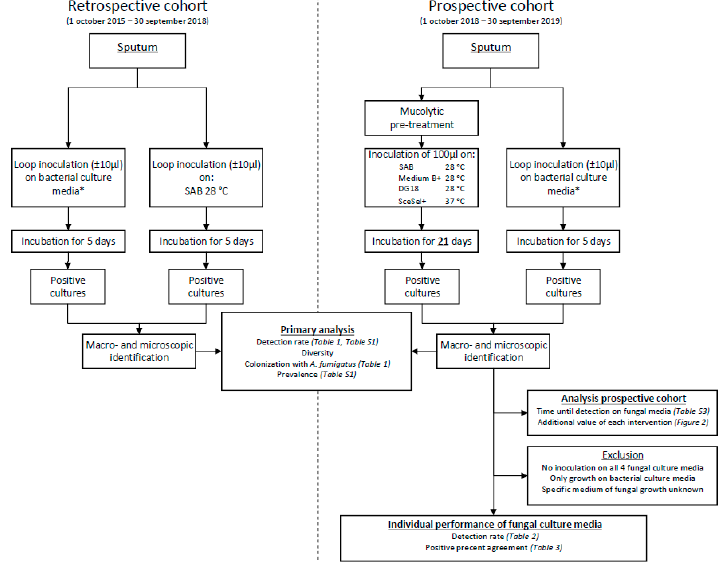
Figure 1. Flow diagram depicting the study design. SAB, Sabouraud; DG18, Dichloran-Glycerol Agar; SceSel + , Scedosporium selective agar. * Bacterial culture media: Columbia III Agar with 5% Sheep Blood 36 ◦ C CO 2 , Chocolate Agar with IsoVitaleXtm and Bacitracine 36 ◦ C anaerobe, MacConkey agar 36 ◦ C O 2 , Burkholderia cepacia selective Agar 36 ◦ C O 2 and Chapman agar 36 ◦ C O 2